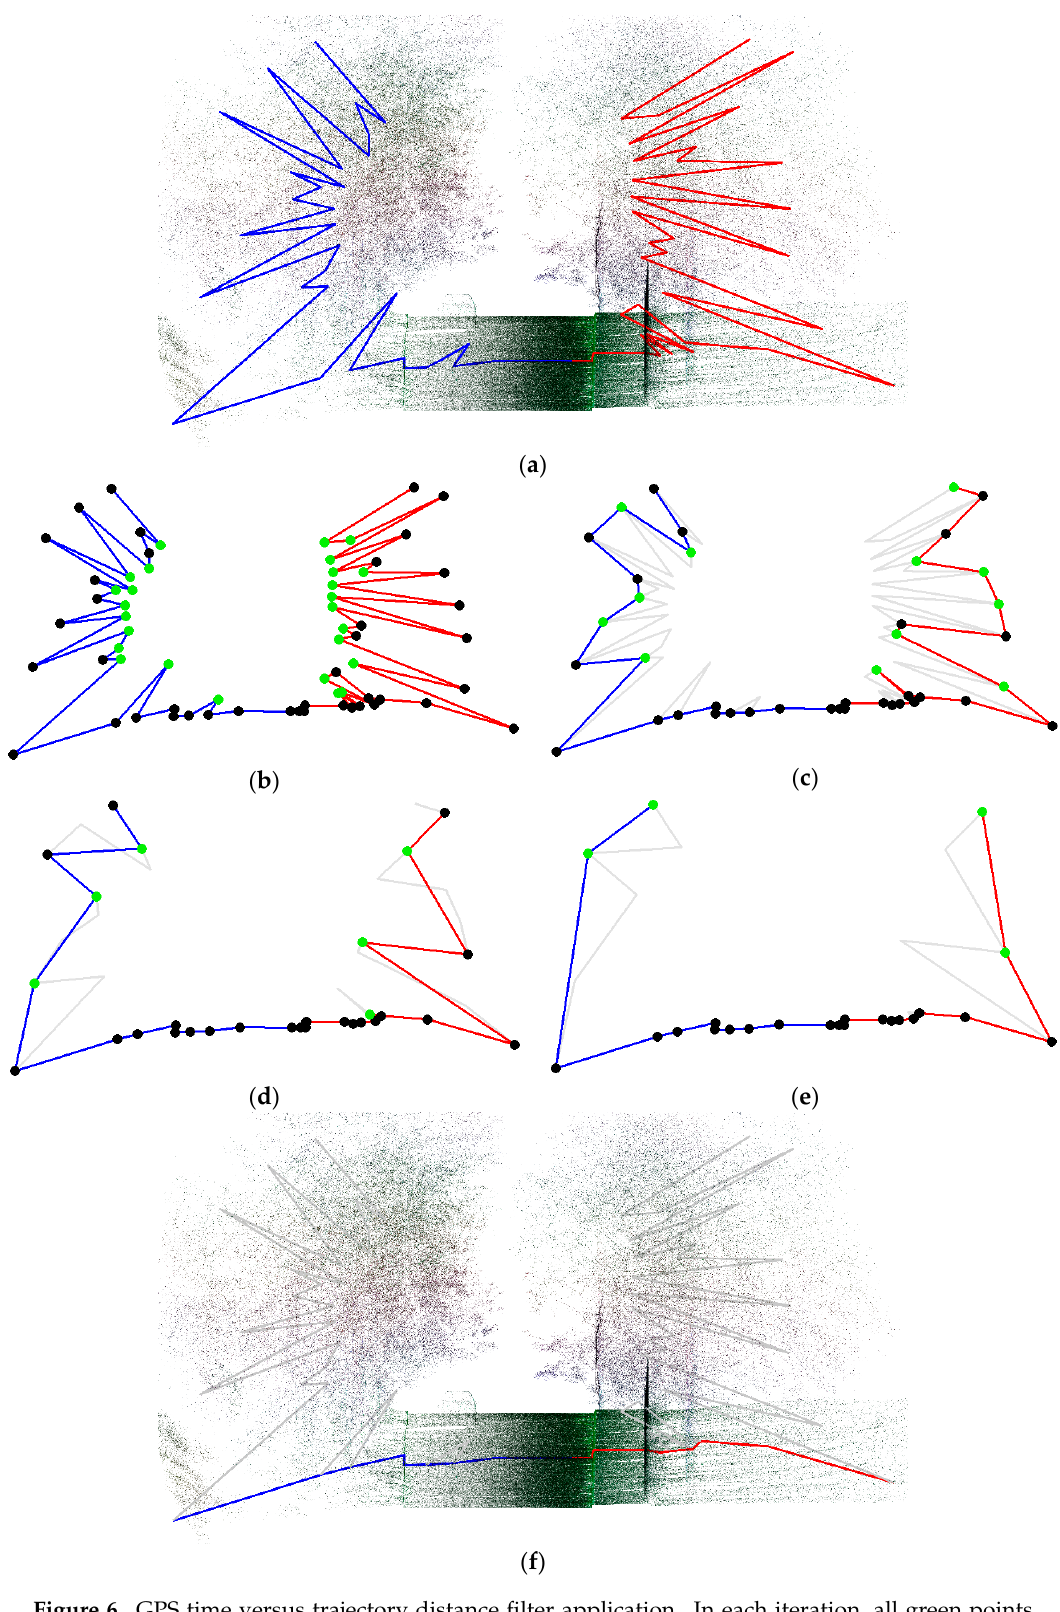
Figure 6. GPS time versus trajectory distance filter application. In each iteration, all green points had a higher trajectory distance than the previous point inside the TCS order and were eliminated: ( a ) original TCS, ( b ) first iteration, ( c ) second iteration, ( d ) third iteration, ( e ) fourth iteration, and ( f ) final TCS result.